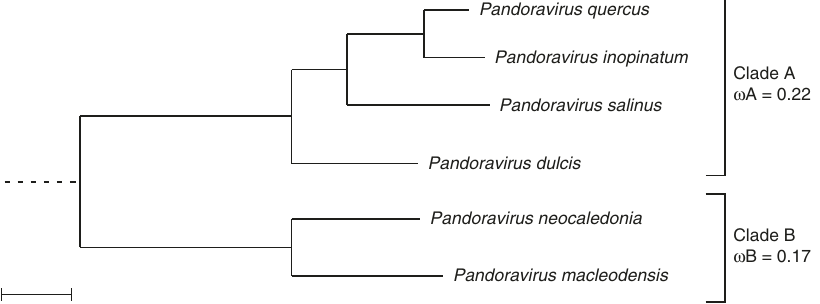
inopinatumP. salinusP. P. Fig. 2 Comparison of the pandoravirus gene contents. a The distribution of all the combinations of shared protein clusters is shown. The inset summarizes the number of clusters and genes shared by 6, 5, 4, 3, 2, and 1 pandoraviruses. b Core genome and pan-genome estimated from the six available pandoraviruses. The estimated heap law α parameter ( α < 1) is characteristic of an open pan-genome 50 and the fl uidity parameter value characteristic of a large fraction of unique genes 51 . Box plots show the median, the 25th, and 75th percentiles. The whiskers correspond to the extreme data points